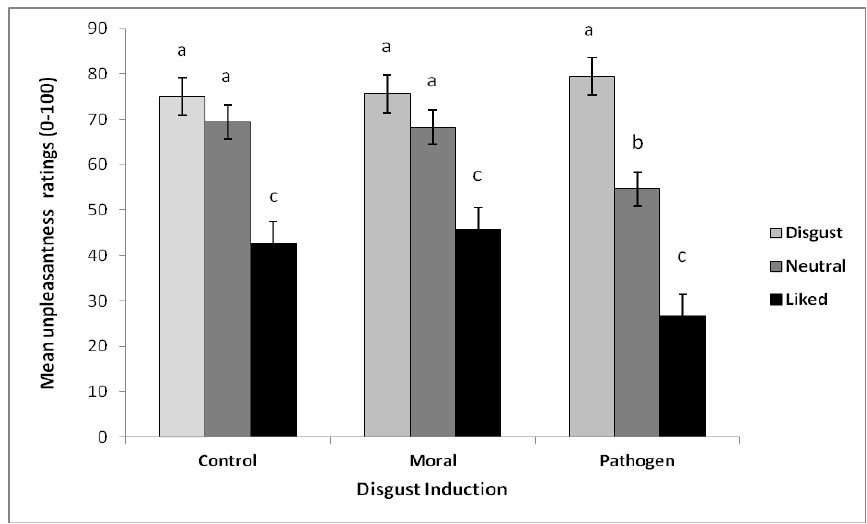
Figure 2. Mean (±SE) unpleasantness ratings dependent on odor and disgust induction Figure 2. Mean ( ± SE) unpleasantness ratings dependent on odor and disgust induction (Experiment 1). (Experiment 1). Note: Letters refer to analyses within each induction group, where mean values Note: Letters refer to analyses within each induction group, where mean values denoted by different denoted by different letters are significantly different from each other: p < 0.001. letters are significantly different from each other: p <